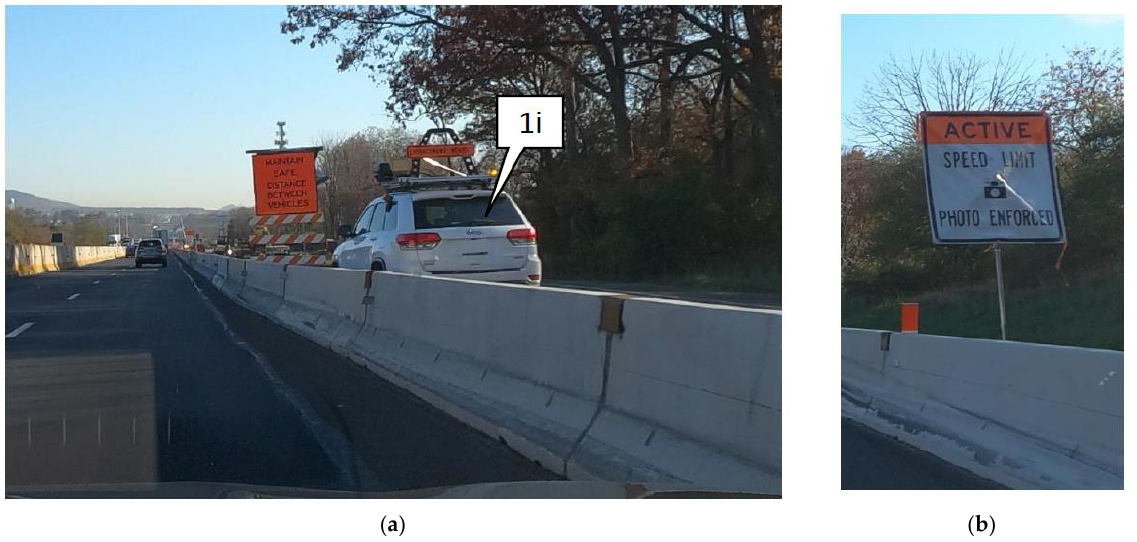
Figure 1. Automated speed enforcement field unit and warning signs. ( a ) Field unit with radar equipment and roof mounted cameras. ( b ) Speed enforcement warning sign. Callout 1i shows the field unit on I-78 work zone in I-78,